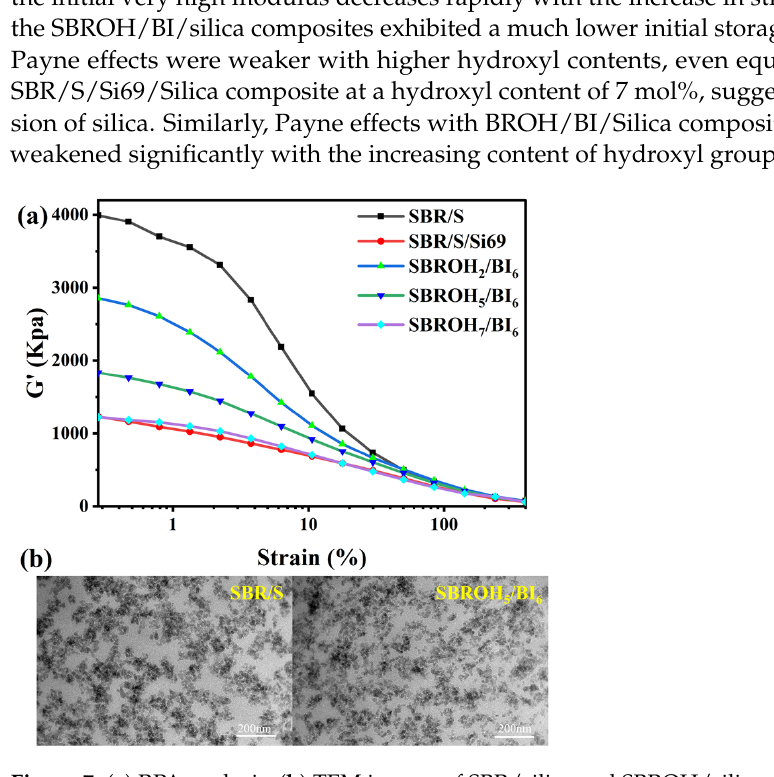
Figure 7. ( a ) RPA analysis, ( b ) TEM images of SBR/silica and SBROH/silica composites.